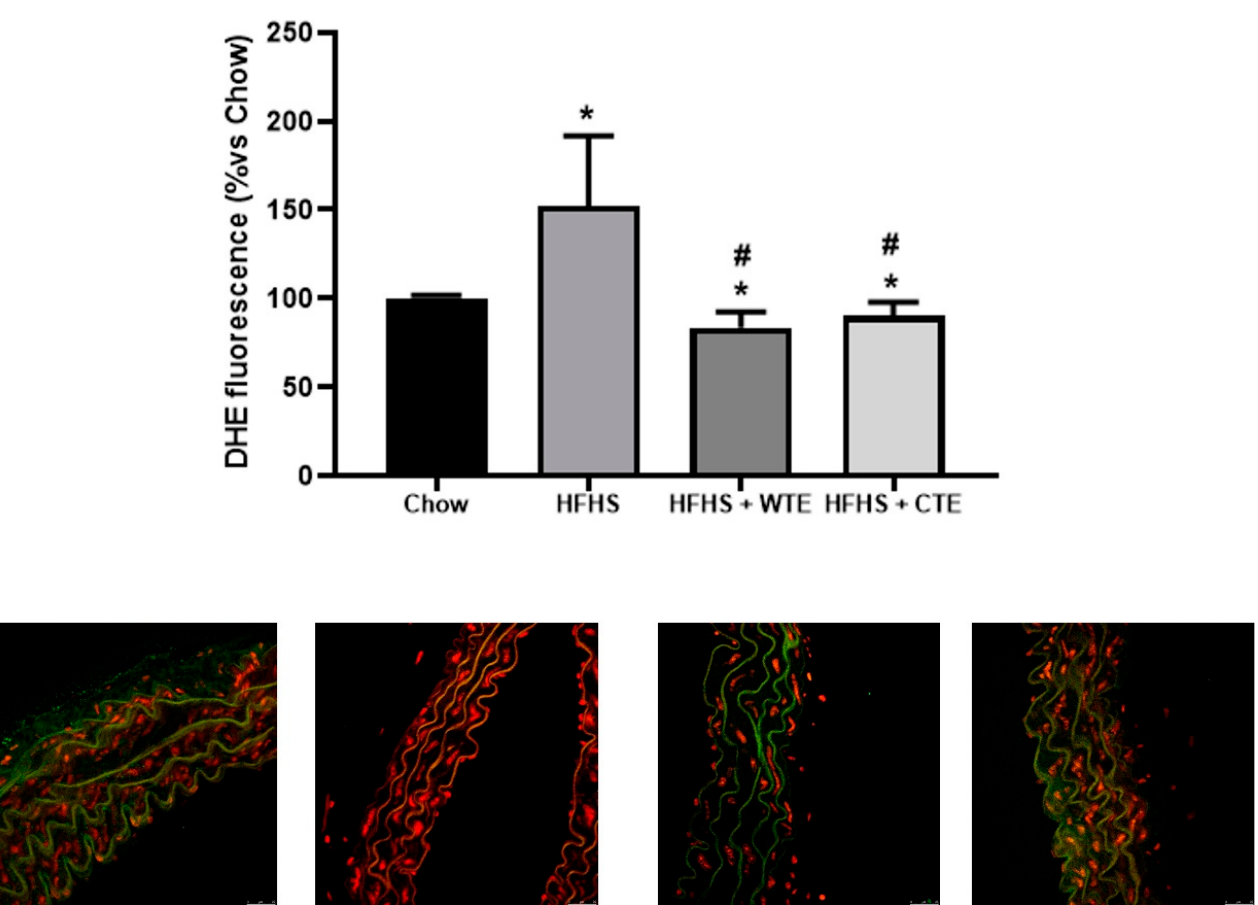
Figure 9. Superoxide anion generation measured as the total DHE fluorescence and respresentative fluorescent microphotographs and quantitative analysis of confocal microspy images in aortic tissue of mice fed a standard diet (Chow), a high-fat diet/sucrose diet (HFHS), a high-fat diet/sucrose diet supplemented with White Tea Extract (HFHS+WTE), or a -high-fat diet/sucrose diet supplemented with Tea Complex Extract (HFHS+TCE). * p < 0.05 vs. chow. # p < 0.05 vs. HFHS. The values are represented as the mean ± S.E.M; n = 7–10 samples/experimental group.